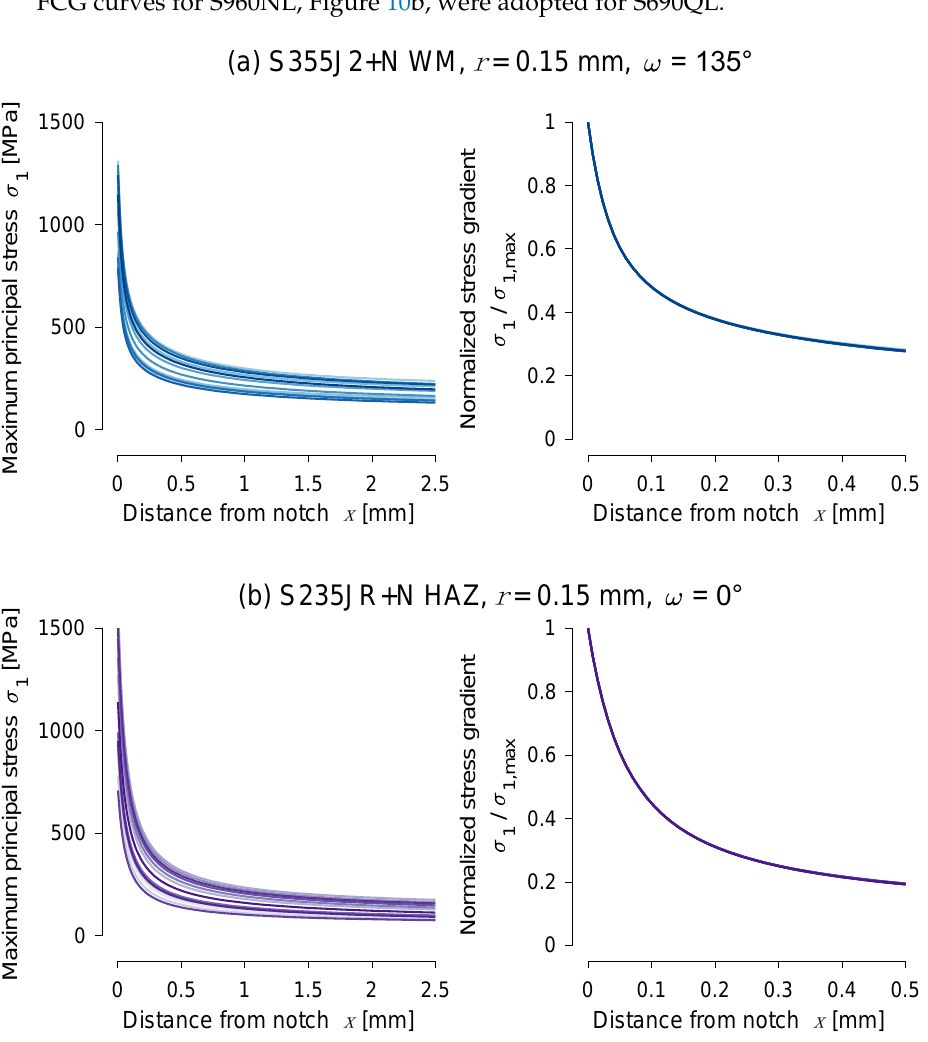
Figure 9. Exemplary stress gradients in crack growth direction of the specimens of series 6 ( a ) and 1 ( b ), as well as corresponding stress gradients normalized with the maximum principal stress at the notch tip.